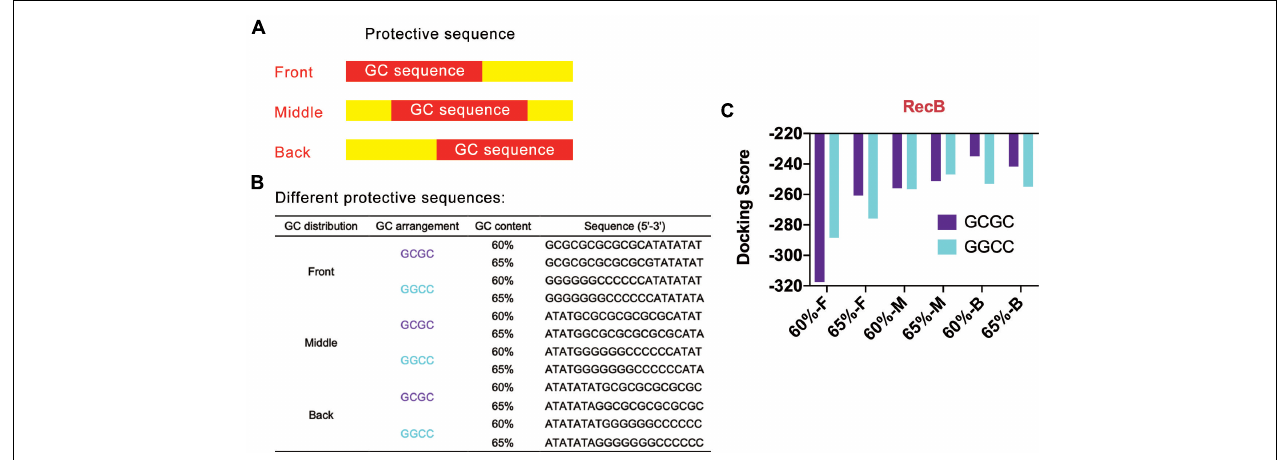
FIGURE 4 | Simulation results of protective sequences with different GC distributions. (A) Schematic diagram of protective sequences with different GC distributions. The GC distribution modes included front, middle, and back. (B) Protective sequences with different GC distributions, arrangements, and contents. The length of protective sequences was 20 bp. (C) Simulation results of RecB subunit with different protective sequences. The 60% and 65% meant different GC contents. The letter F, M, and E meant the GC distribution mode was front, middle, and back. These protective sequences had two different GC arrangement modes, including GCGC and